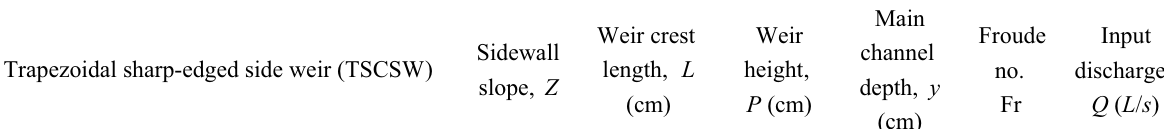
Trapezoidal sharp-edged side weir (TSCSW)